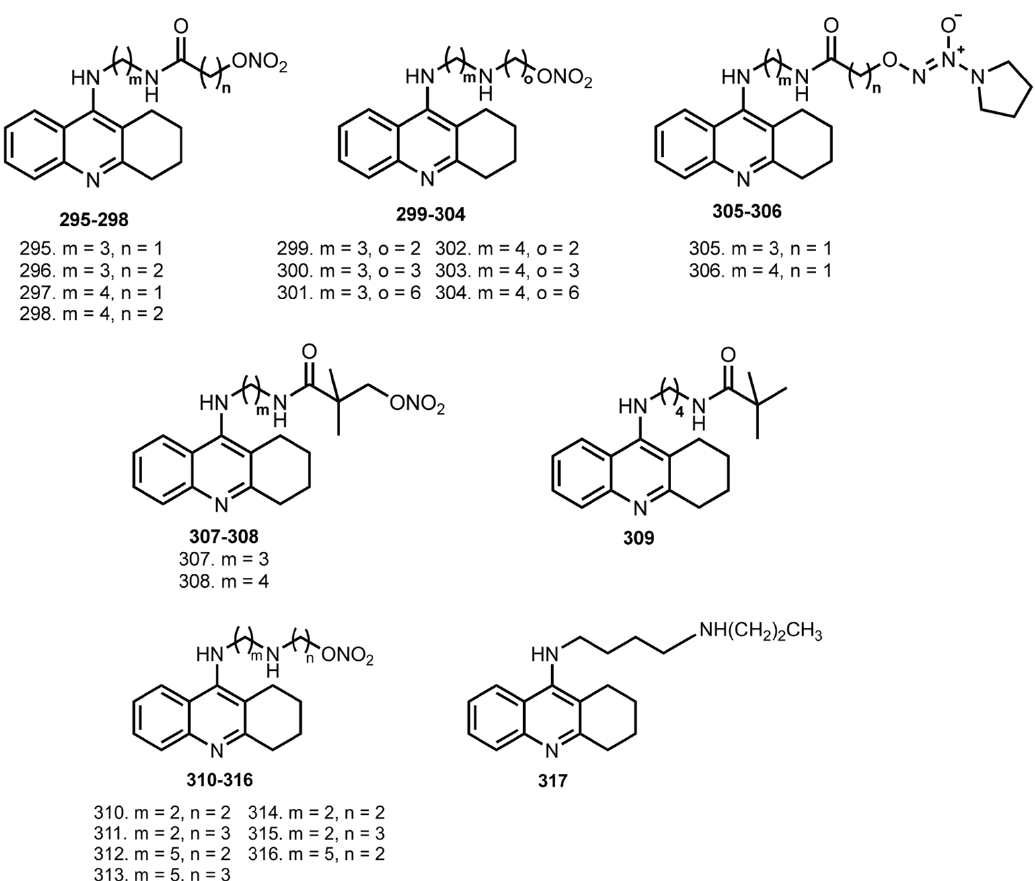
Figure 11. THA hybrids with NO ‐ donating moieties 295 – 308 and model compound 309 [64], hybrids 310 – 316 , and model 317